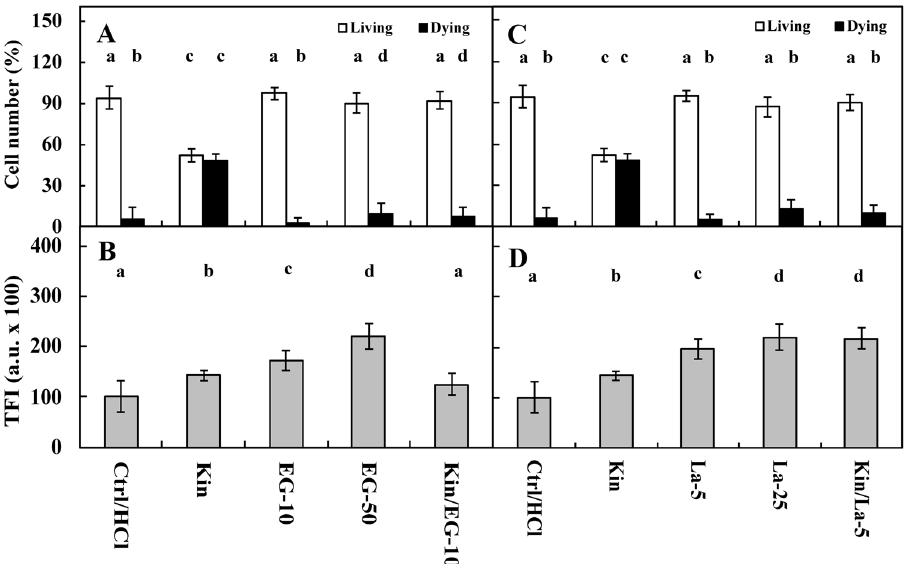
Figure 5. Number (%) of living and dying cells ( A , C ) as well as cytosolic calcium (Ca 2+ ) ion amounts ( B , D ) in Vicia faba ssp. minor cortex seedling apical roots after treatment with EGTA (EG, ethylene glycol-bis( β - aminoethyl ether)-N,N,N ′ ,N ′ -tetraacetic acid; A , B ) and lanthanum chloride (La 3+ ; C , D ). The number of living and dying cells as well as the amounts of Ca 2+ were fluorescently estimated after staining with acridine orange, ethidium bromide and chlortetracycline. Bars indicate ± SE of the results from three biological replicates. The means of the results with the same letter above the column are not significantly different at p ≤ 0.05. Ctrl, control; Kin, kinetin, EG–10,10 μM EGTA; EG–50, 50 μM EGTA; La–5, 5 μM La 3+ ; La–25, 25 μM La 3+ ; Kin/EG–10, Kin with 10 μM EGTA; Kin/La–5, Kin with 5 μM La 3+ ; Kin/La–25; Kin with 25 μM La 3+ ; TFI, total (integrated) fluorescence intensity.